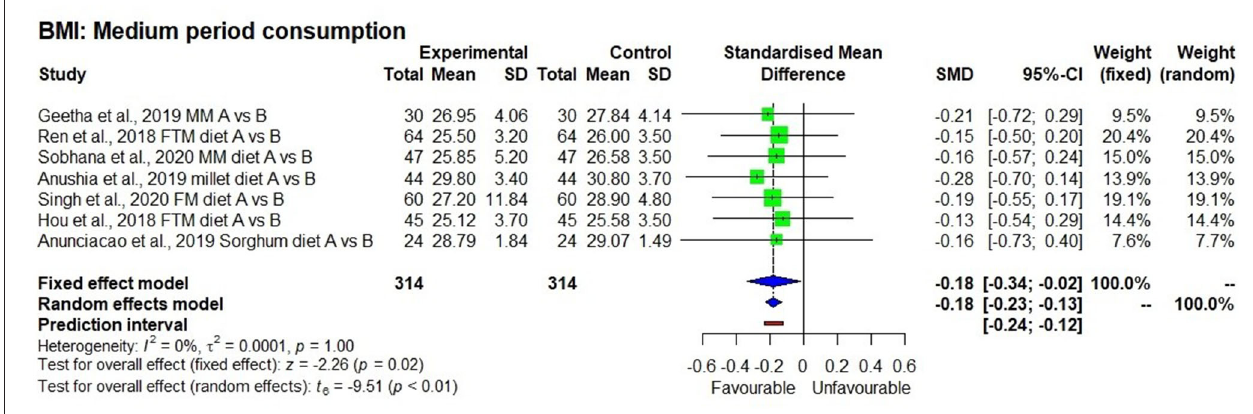
FIGURE 8 | Effect of consuming millets on BMI of the participants (pre- vs. post-treatment).